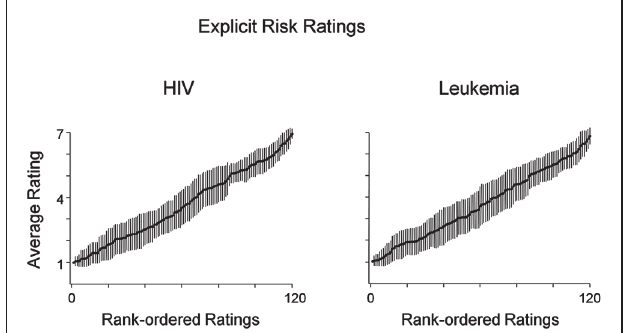
FIGURE 1 | Average ratings of HIV and leukemia risk . Average ratings of HIV and leukemia risk and associated standard errors after rank-ordering each participant’s ratings by HIV and leukemia risk, respectively. Participants’ ratings of HIV and leukemia risk similarly varied across the full range of the scale (1—low risk; 7—high